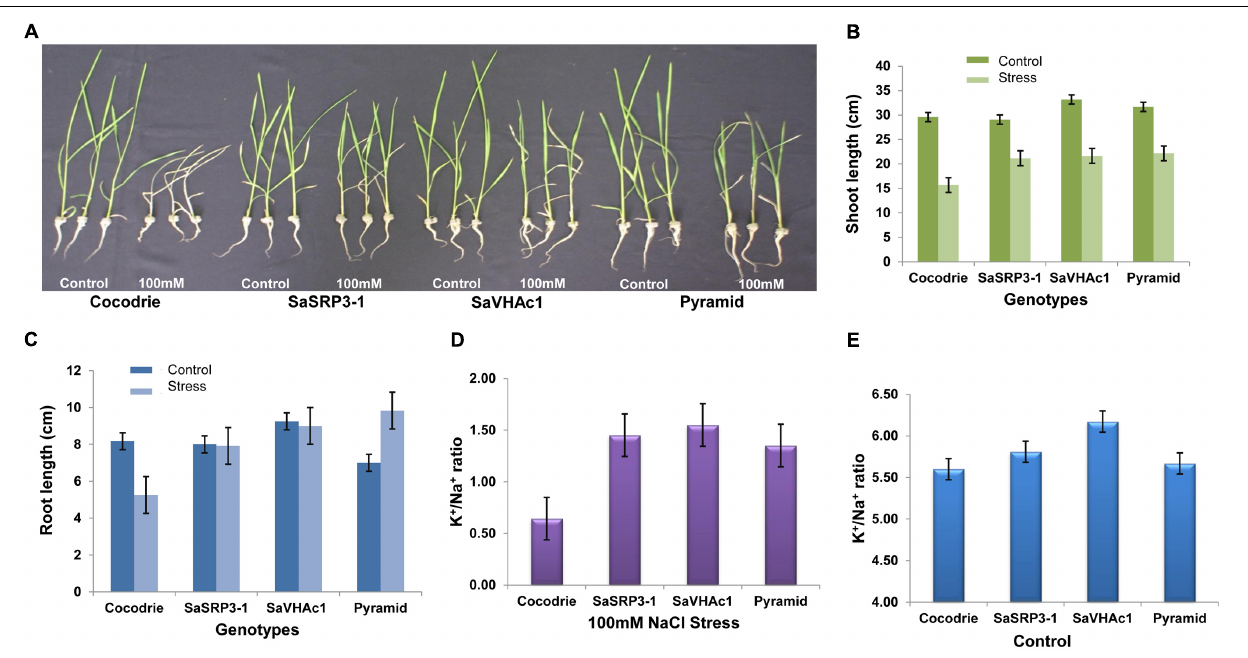
FIGURE 5 | Salt tolerance evaluation of transgenic and wild type plants. (A) Responses of transgenic and wild type rice plants to 100 mM NaCl stress during seedling stage; (B) Comparison of shoot length; (C) Comparison of root length; (D) K + /Na + ratio in shoot 12 days after exposure to 100 mM salt stress; (E) K + /Na + ratio in shoot under control condition; Values represent means ± SD of five independent replicates. Error bars represent standard